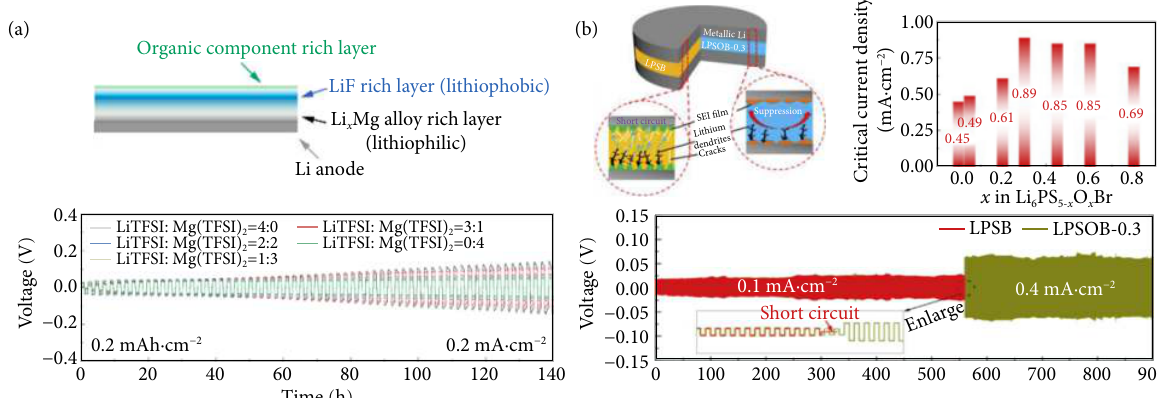
Fig. 8 (a) Illustration of in situ formation of the Li x Mg/LiF/polymer solid electrolyte interphase between Li and LGPS and galvanostatic cycling of the Li/LGPS/Li cell using different LiTFSI–Mg(TFSI) 2 –DME-treated LGPS (reprinted with permission from ref. [102], © 2021 American Chemical Society). (b) Schematic of the excellent dendrite suppression capability for LPSOB-0.3 in contrast to LPSB, the critical current density of the Li/Li 6 PS 5− x O x Br symmetric cells and galvanostatic cycling of Li/ LPSOB-0.3/Li and Li/LPSB/Li cells (reprinted with permission from ref. [103], © 2019 Elsevier